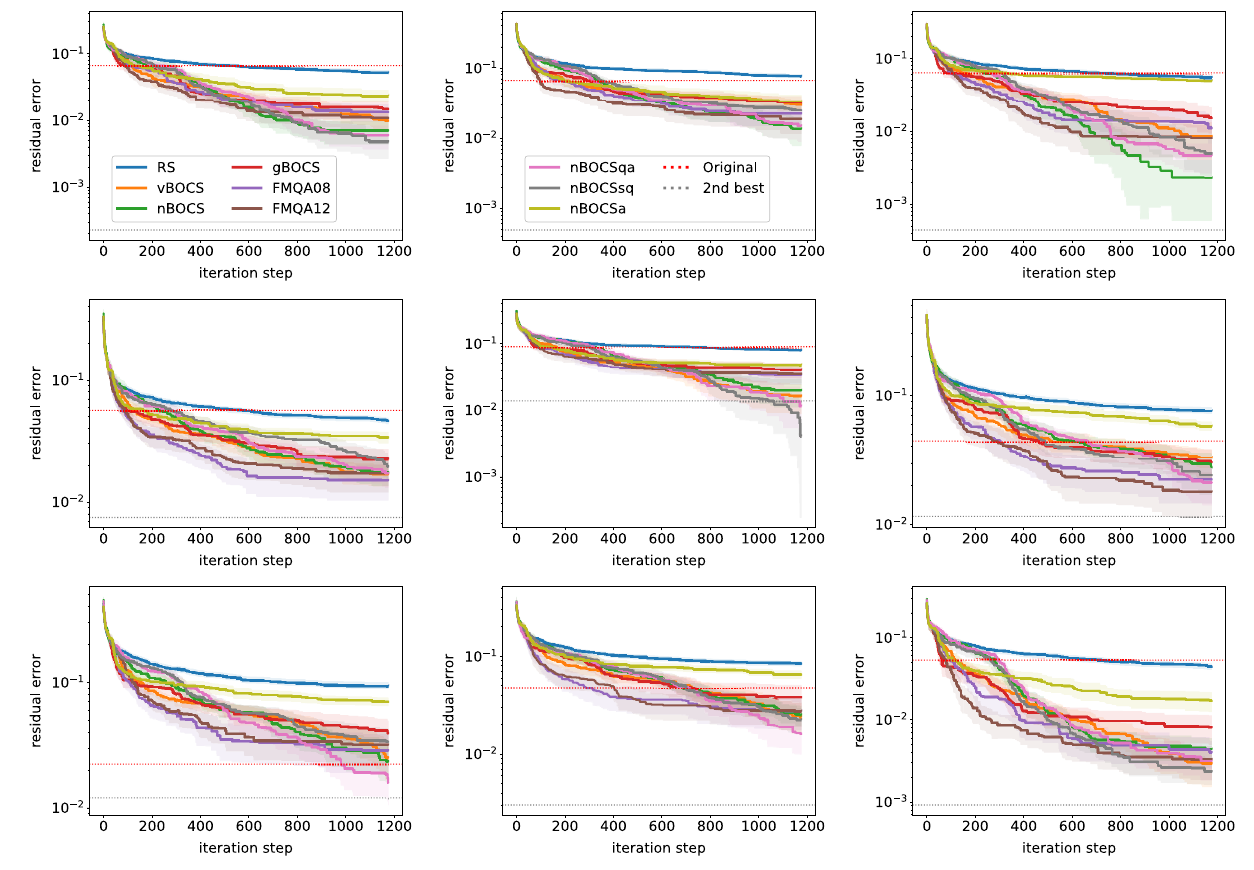
Figure 7. The residual error of lossy compression of the other nine matrices (instances) as a function of the iteration step among various algorithms with 95% confidence intervals. The errors of the nine exact solutions (baseline of the plots) are 0.535, 0.388, 0.509, 0.487, 0.488, 0.379, 0.367, 0.422, and 0.520,